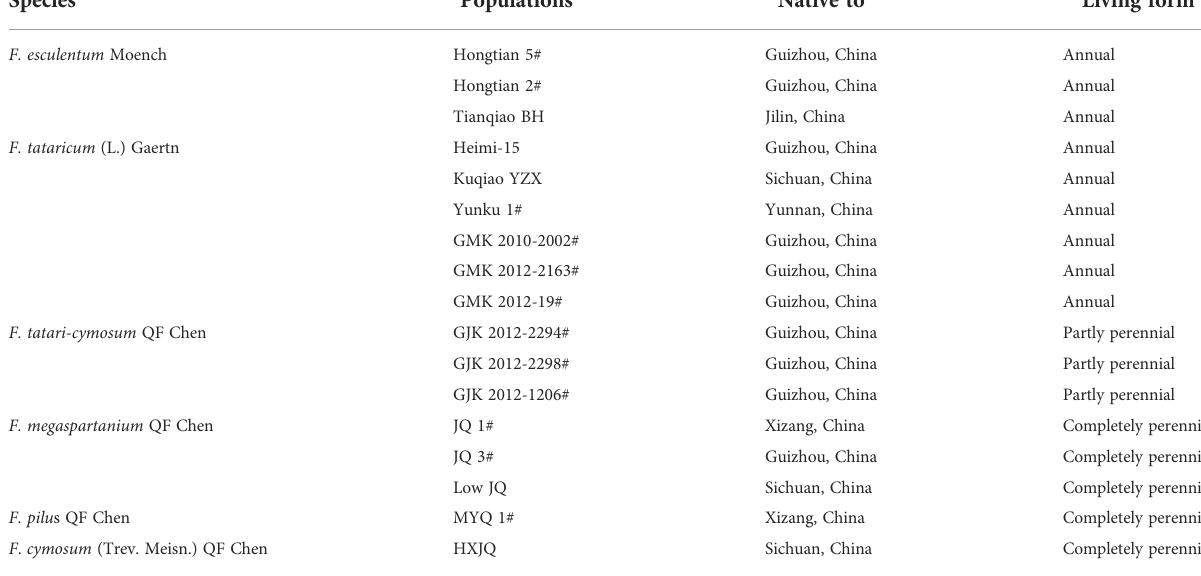
TABLE 1 Plant materials studied. Species Populations Native to Living